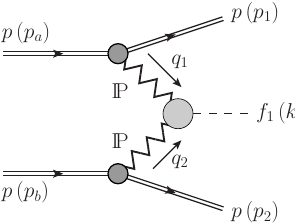
Figure 1: Diagram for the reaction (1) with double-pomeron